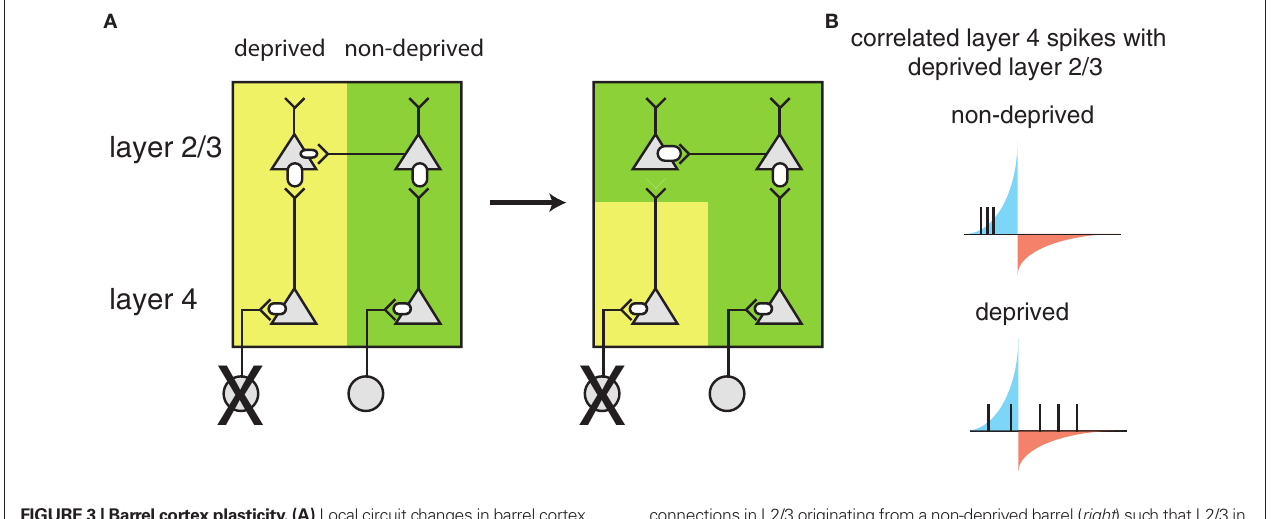
Figure 3 | Barrel cortex plasticity. (A) Local circuit changes in barrel cortex following whisker deprivation. Shown are layer 4 (L4) and layer 2/3 (L2/3) cells and their excitatory synaptic connections. The size of the receptors indicates the strength of the synapse. Yellow shading indicates cells driven by the deprived barrel and green shading indicates cells driven by the non-deprived barrel. Reducing sensory input to one barrel by whisker deprivation (deprived) ( left ) results in weakening of L4 to L2/3 synapses and strengthening of horizontal